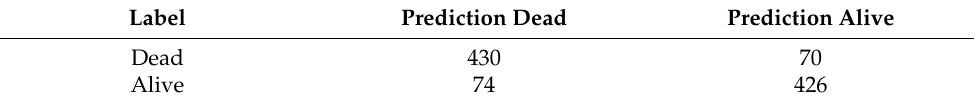
Table 9. Confusion matrix of the validation sequences classified by the neural network with the model trained with a mixed dataset.